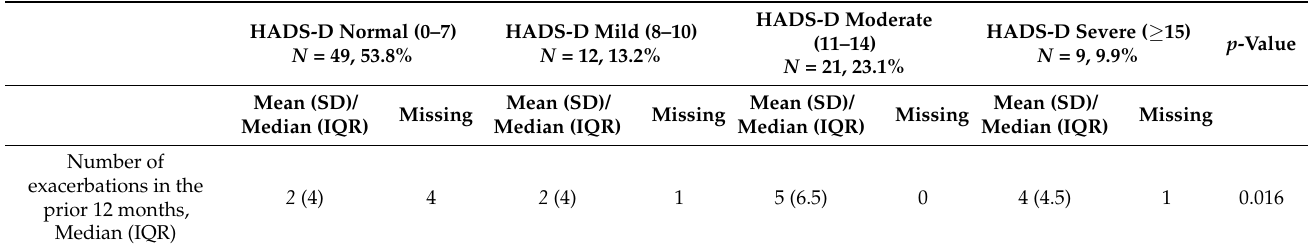
Table 6. Asthma outcomes for those with a clinical diagnosis of dual anxiety and depression by HADS-D